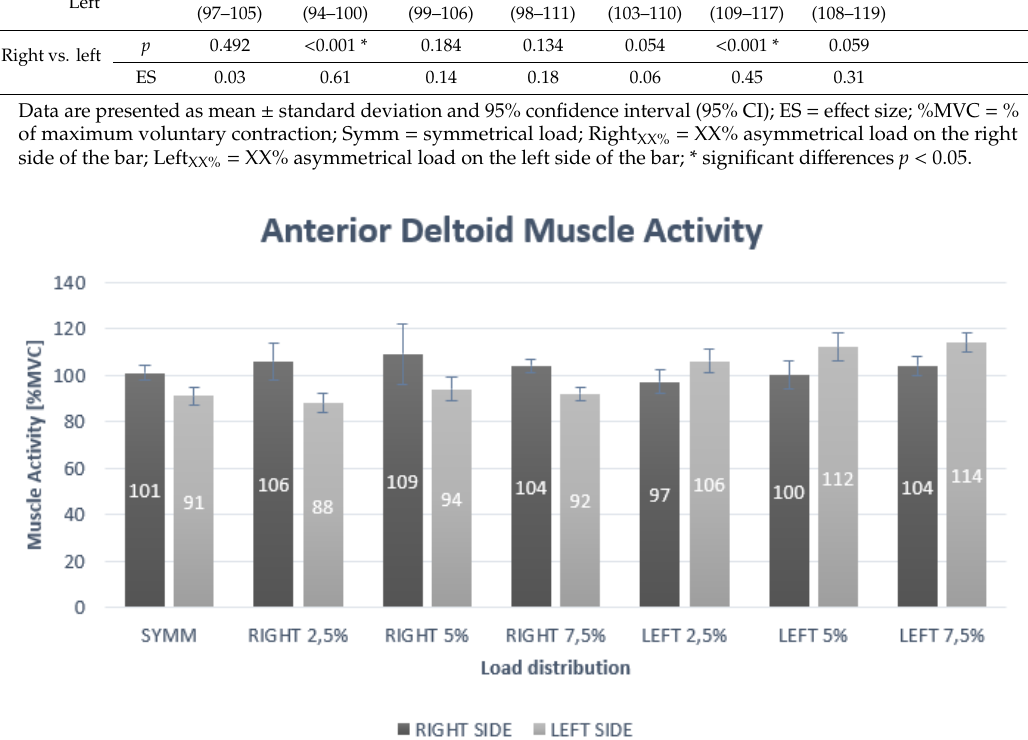
Figure 2. Muscle activity of pectoralis major under different loading positions. 4.3. Triceps Brachii In the case of the TB muscle, the results of the two-way repeated measures ANOVA showed a significant interaction for side and load ( p < 0.01; F = 10.59; η 2 = 0.29) for the TB muscle. The post-hoc analysis for the interaction effect of side × load showed statistically significant differences at 2.5% right asymmetric loading and for the 5% left asymmetric loading (Table 1, Figure 3).